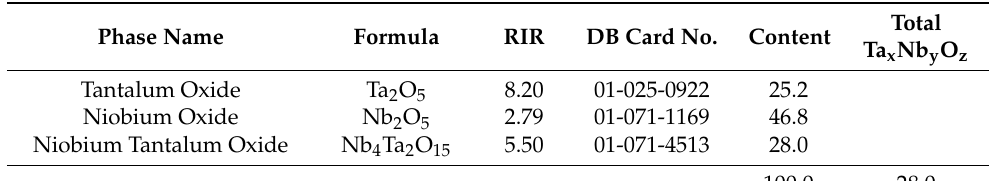
Table 2. Quantitative XRD (phase) analysis results (WPF, combined with RIR) of a 70 mol% Nb 2 O 5 to